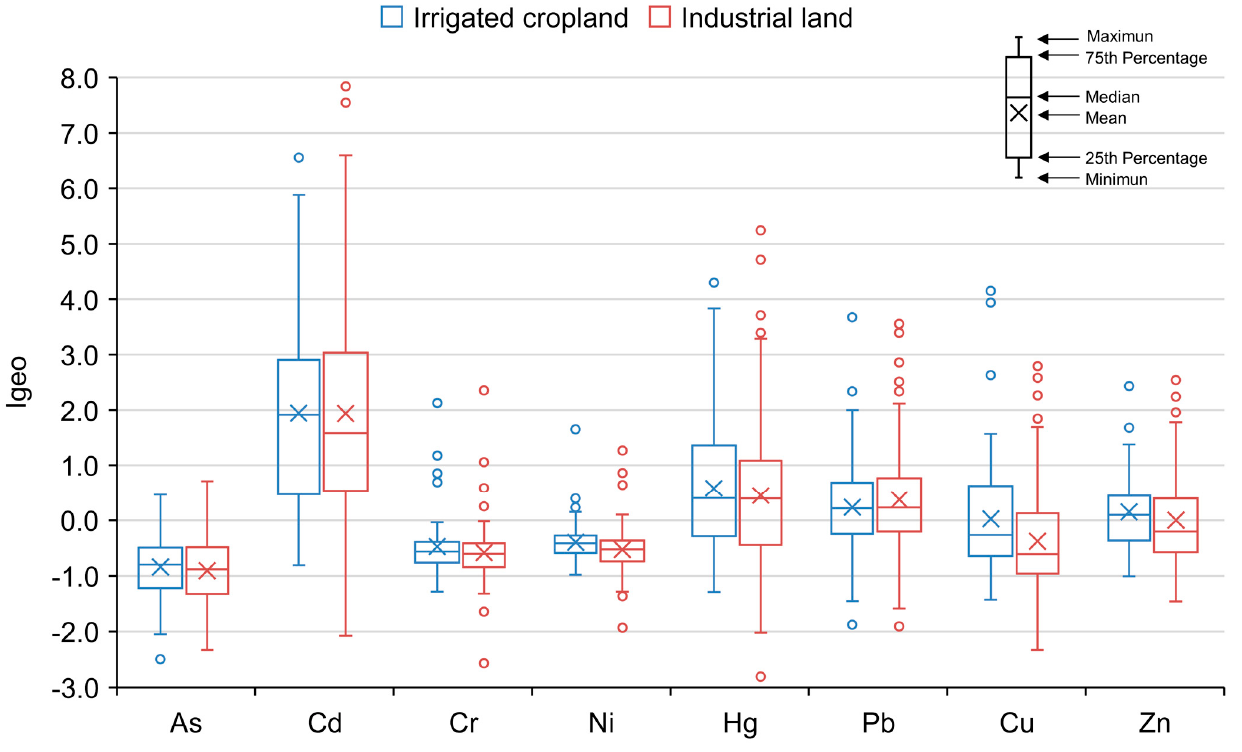
Figure 2. Heavy element boxplots of the index of geo-accumulation under two land covers (irrigated cropland and industrial land). cropland and industrial